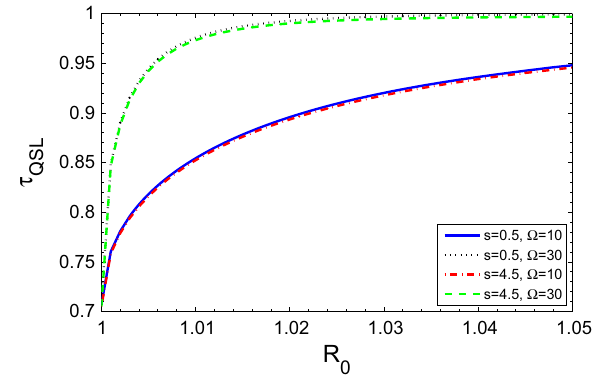
Fig. 10 The QSL-time for the Ohmic-like dephasing model as a func- tion of the R 0 . The value of driving time is τ D = 1 and initial time τ = 0